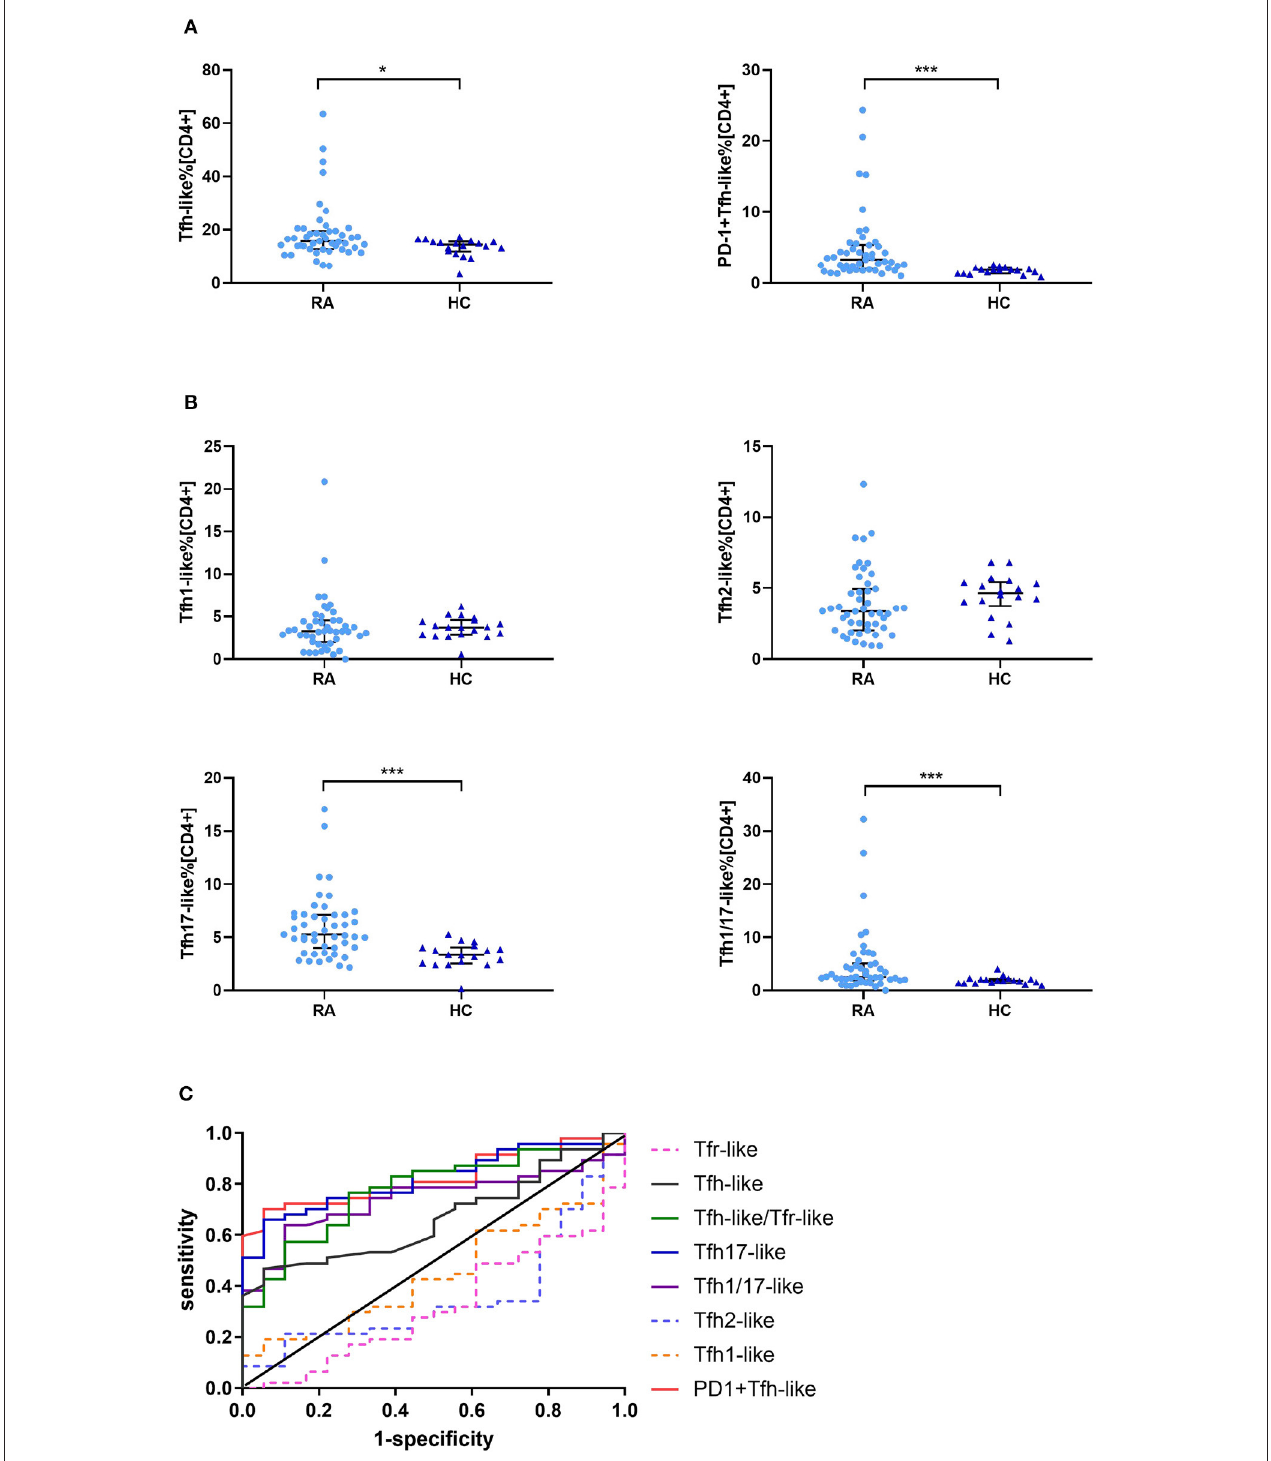
FIGURE 2 | Tfr-like and Tfh-like cell subsets in RA patients and healthy controls. (A) Frequencies of Tfh-like and PD-1 + Tfh-like cells in patients with RA and healthy controls. (B) Frequencies of Tfh-like cell subsets in patients with RA and healthy controls. (C) The Tfh-like/Tfr-like cell ratio, Tfh-like cells, and Tfh17-like, Tfh1/17-like, and PD-1 + Tfh-like cell subsets as biomarkers of RA. Data in (A,B) are shown as the median and interquartile range. The Mann–Whitney U -test was used to compare the median values. * p < 0.05, *** p < 0.001. Tfr-like, T follicular regulatory-like; Tfh-like, T follicular helper-like; Treg, T regulatory.